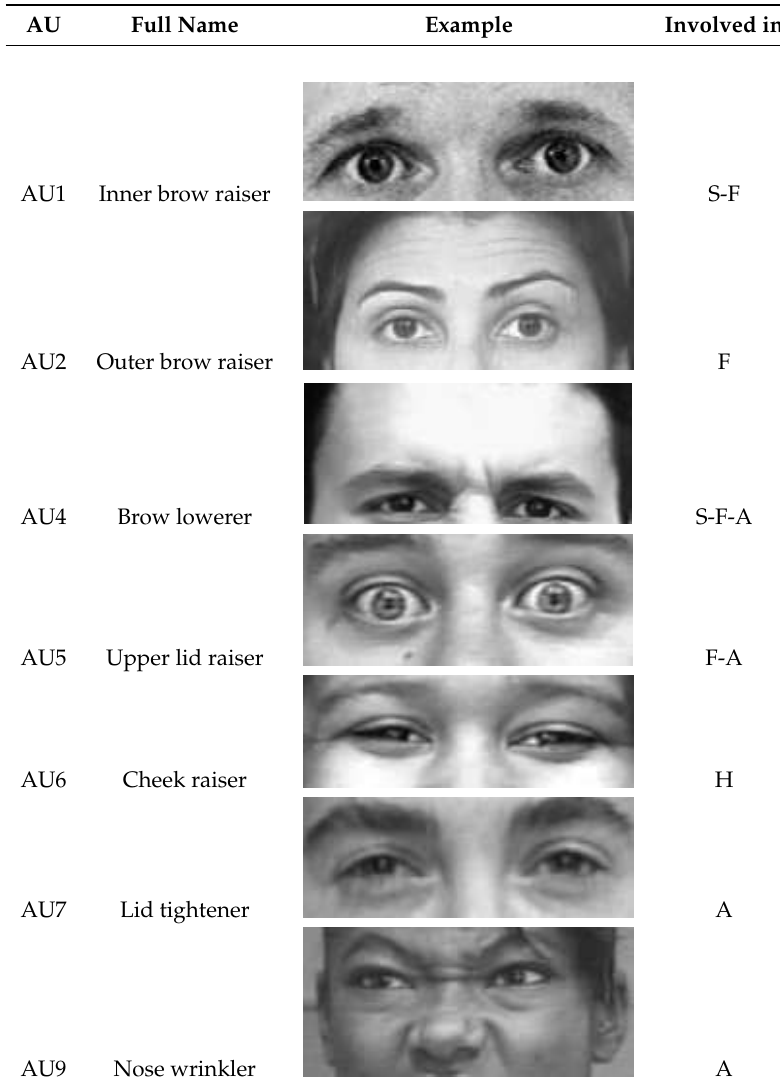
Table 1. Action Units used for monitoring the ability in producing the foru basic facial expressions (H = Happiness; S = Sadness; F = Fear; and A =